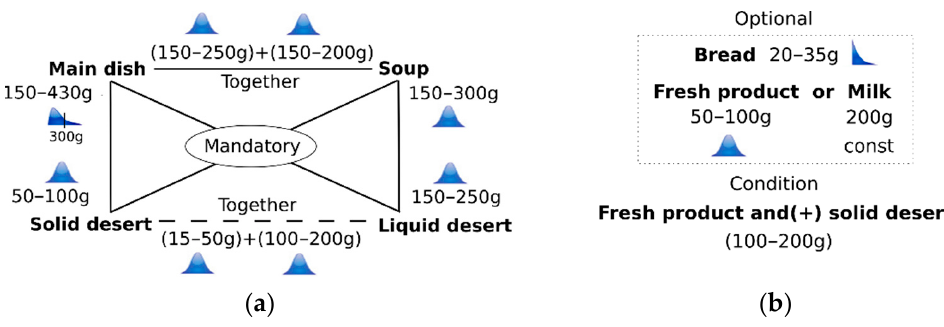
Figure 2. Generation model of a lunch portion: ( a ) mandatory part; ( b ) optional part.